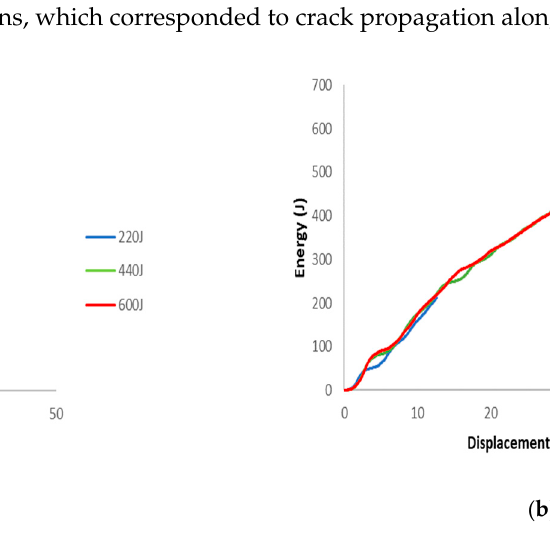
Figure 6. Representative results of ( a ) force-displacement and ( b ) energy-displacement for dynamic experimental test .